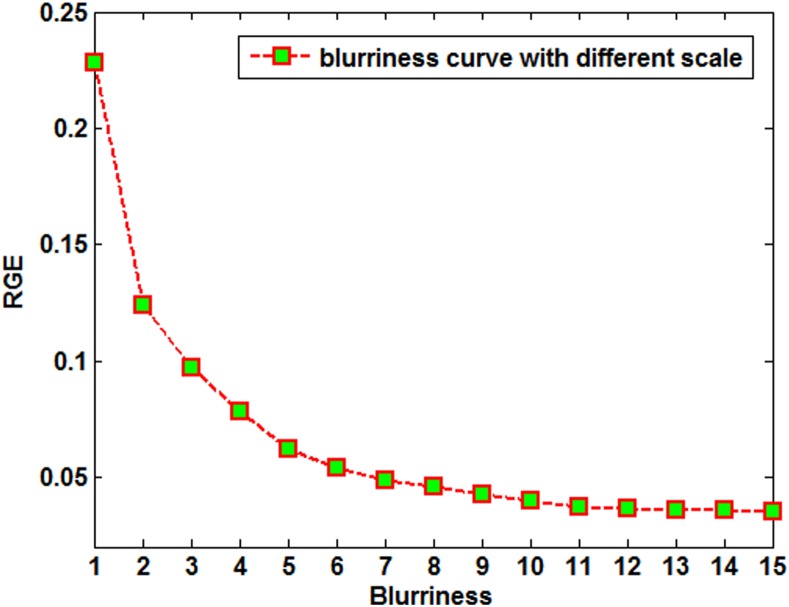
Blurriness curves corresponding to Fig. 3.